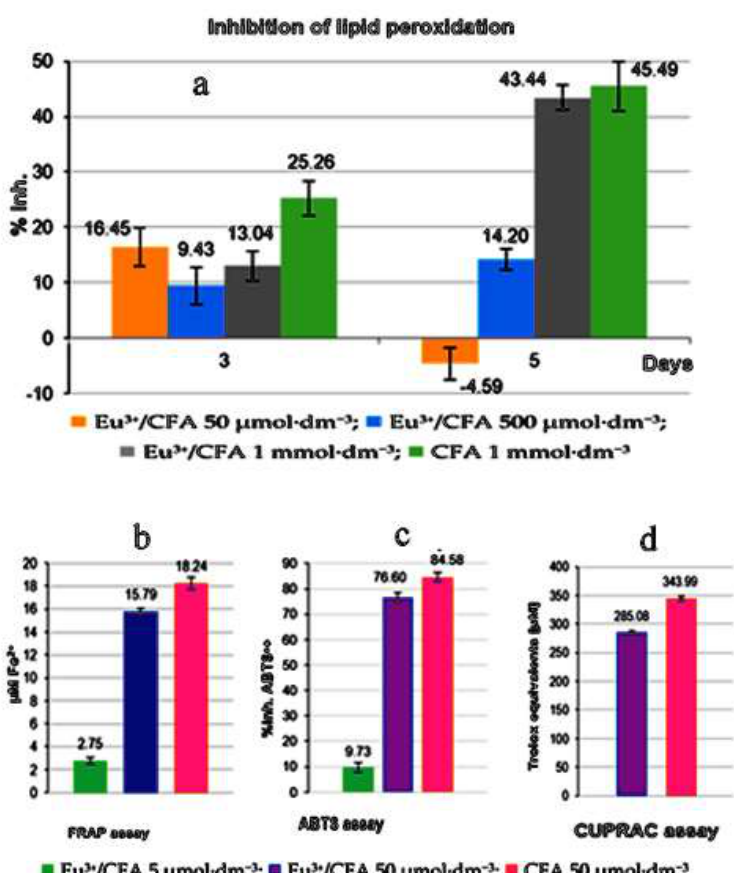
Figure 7. ( a ) % of reduction in oxidative stress by Eu 3+ /CFA complicated at 50, 500, and 1000 mol dm − 3 ; ( a ) CFA and Eu-CFA antioxidant properties assays at the identified concentration level ( b ) FRAP assay assessment of reducing possibility; ( c ) proportion of inhibition of ABTS • + cation radicals; ( d ) CUPRAC test findings demonstrated as Trolox offerings [mol · dm 3 ]. Mean results from three independent tests ± SD are shown. Reproduced from the permission of ref. [139].